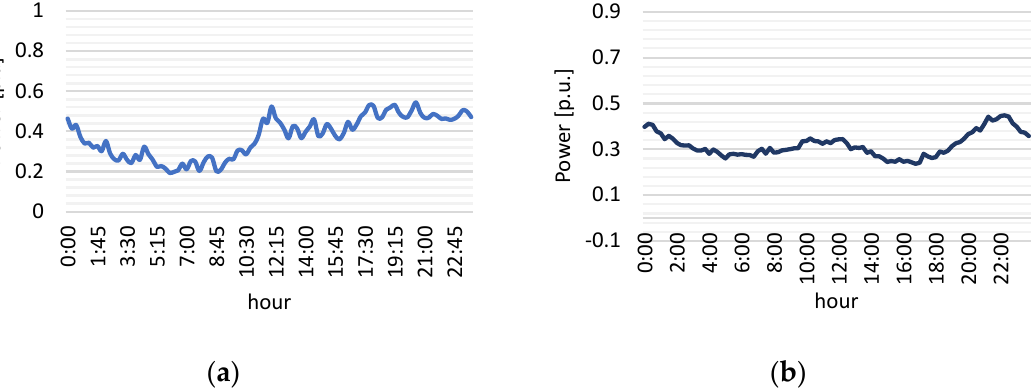
Figure 9. “Slim mount profile” obtained in industrial clients I1 and I2 (S) and in commercial clients C2 (S). ( a ) The left curve corresponds to an industrial customer, and ( b ) the right curve corresponds to a commercial customer.